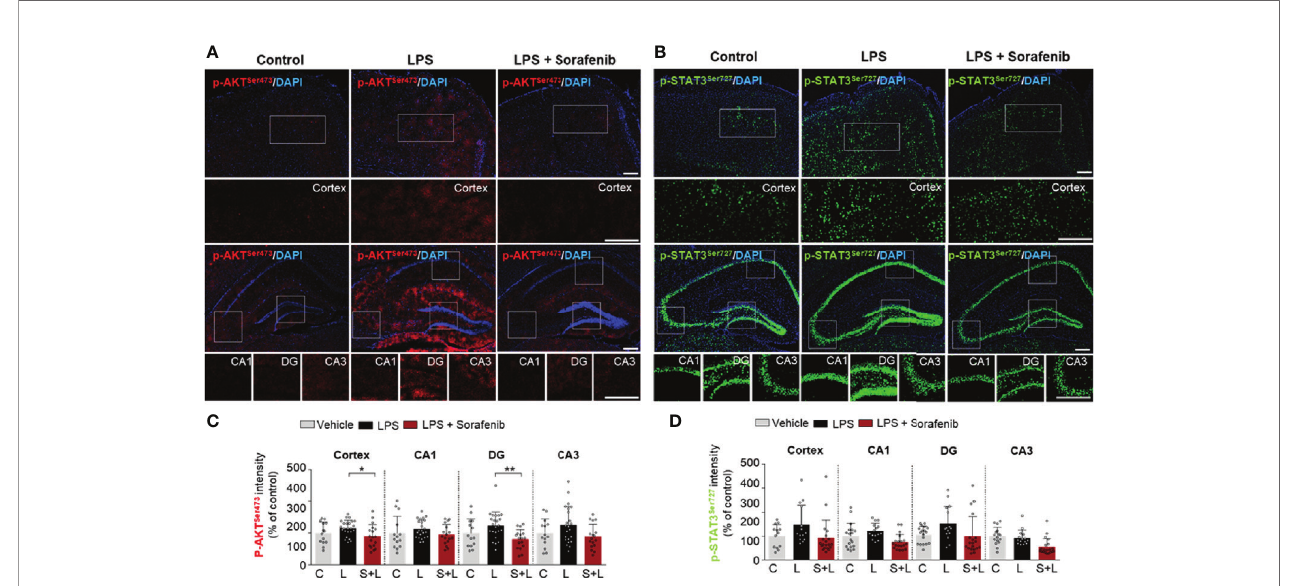
FIGURE 7 | Posttreatment of sorafenib diminishes LPS-evoked AKT phosphorylation in wild-type mice. (A , C) Immuno fl uorescence staining with anti-p-AKT S473 and anti-p-STAT3 S727 antibodies of brain slices from wild-type mice treated with LPS followed by sorafenib. (B, D) Quanti fi cation of the data in A, C (analyzed number of brain slices/images (n); p-AKT S473 : Vehicle, = 14; LPS, n=24; LPS + Sorafenib, n=18, p-STAT3 S727 , Vehicle, n=13; LPS, n=14; LPS + Sorafenib, n=20). *p < 0.05, **p < 0.01, Scale bar = 200 m